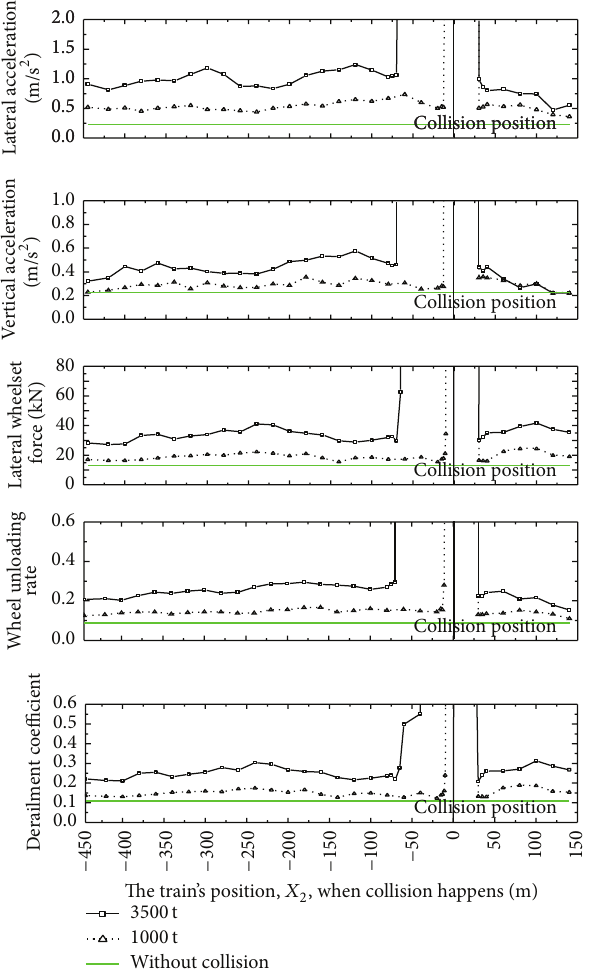
Figure 18: Influence of the tonnage of the ship.